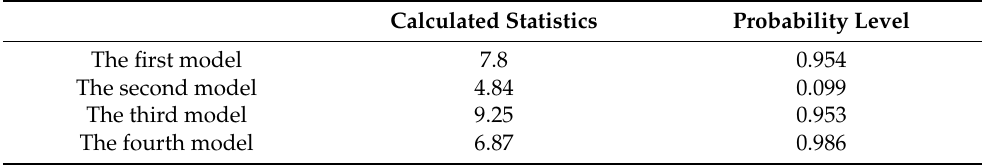
Table A4. The Hausmann test results.